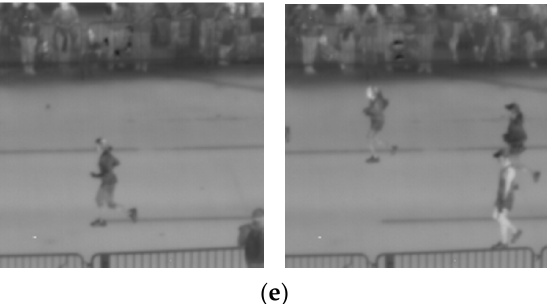
Figure 5. Example images of dataset: the left images in red boxes show the cropped ROI, the middle images in green boxes represent the GT images, and the right images in blue boxes show the input images to model for image prediction. ( a – c ) the procedure of making the dataset; ( d ) example images used in training phase; ( e ) example images used in testing phase.